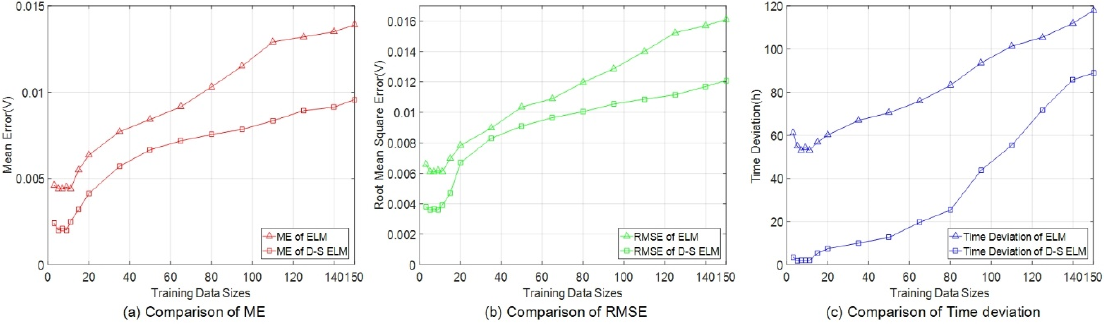
Figure 9. Comparisons of different training data sizes.